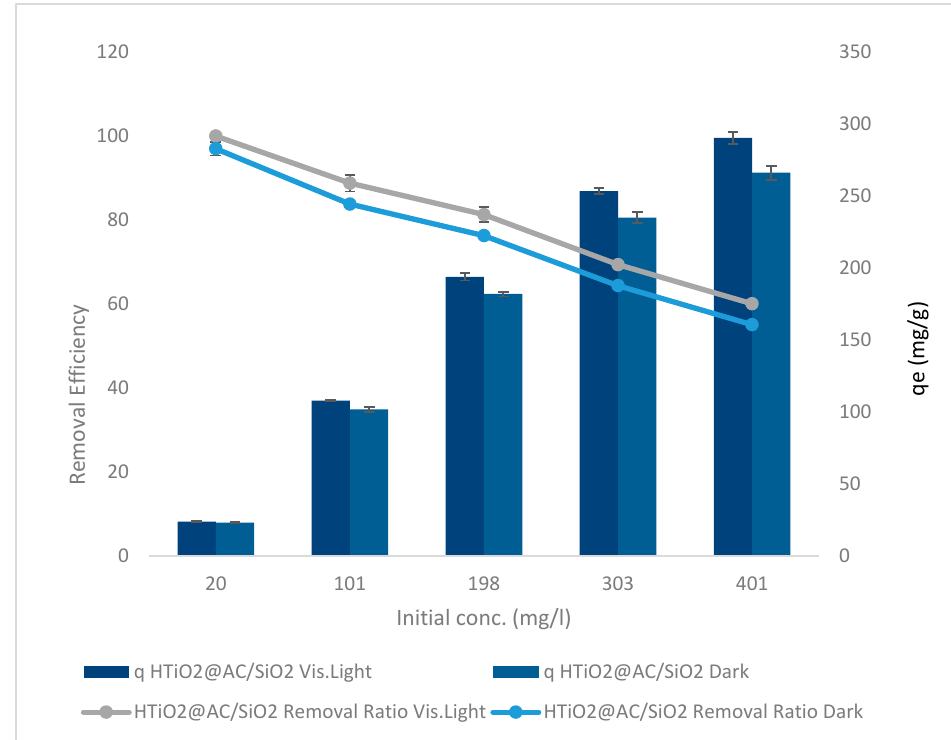
Figure 8. The initial oxamyl concentration HTiO 2 @AC/SiO 2 in dark and visible light. The results of using HTiO 2 @AC/SiO 2 in dark and visible light are shown in Figure 8. Increasing the initial oxamyl concentration from 20 to 401 mg L − 1 linearly decreased the oxamyl removal ratios from 97% to 55% and 100% to 60%, with r 0.99, p 0.0004, and r 0.997, p 0.0001, respectively. While q e elevated from 23.4 to 266.2 mg g − 1 , with r 0.979, p 0.003, and 24.1 to 290.4 mg g − 1 , with r 0.983, p 0.003, in dark and visible light, respectively.